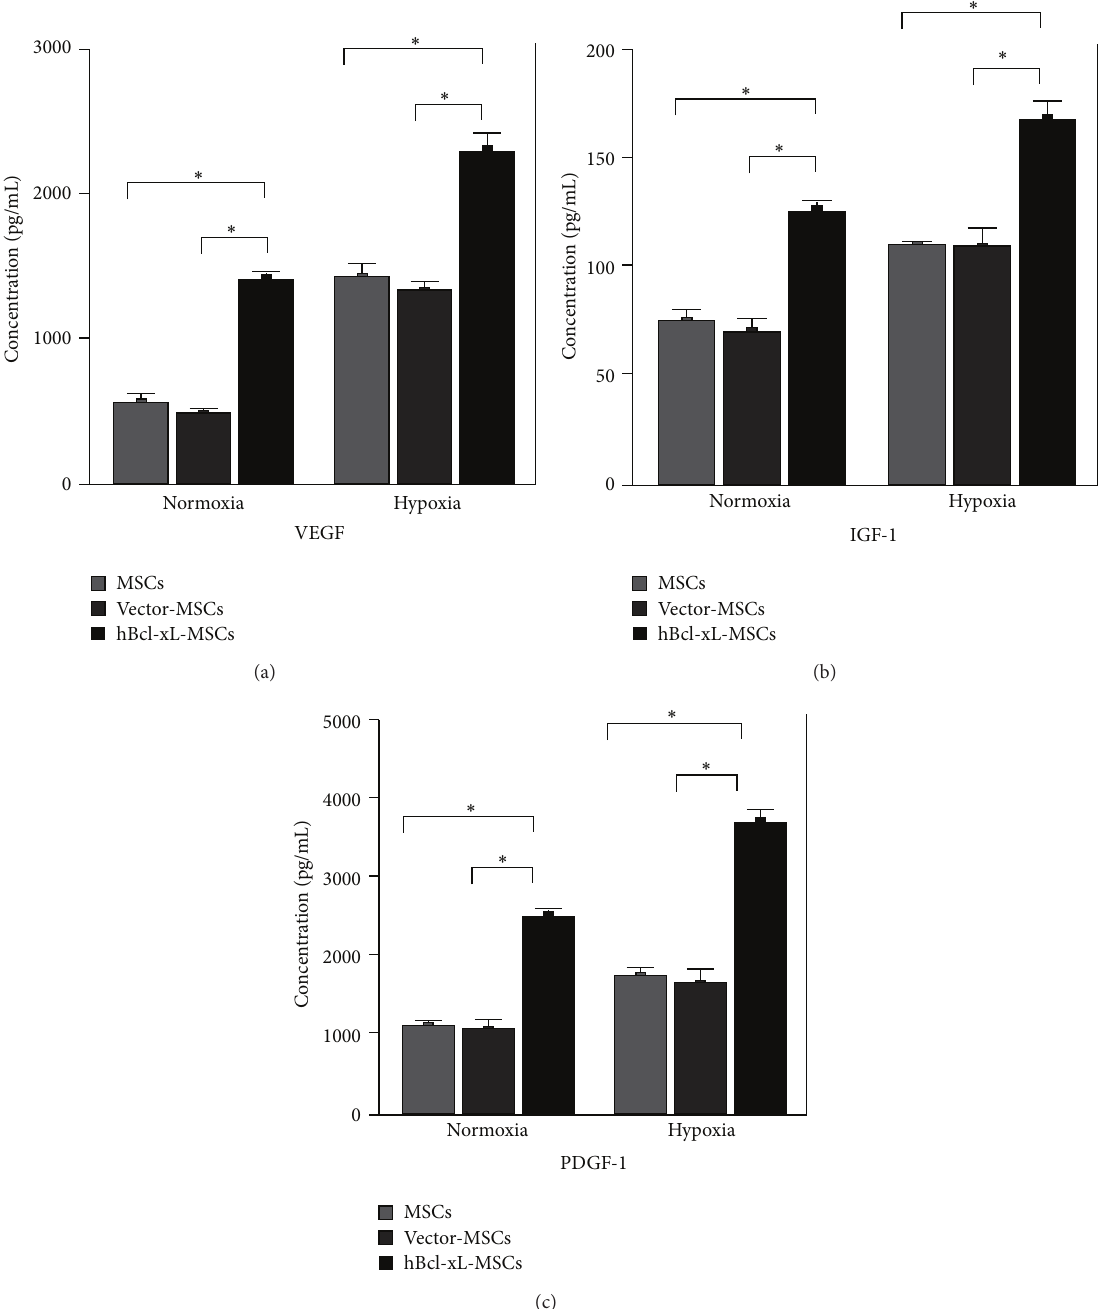
Figure 4: Upregulation of angiogenic cytokines in hBcl-xL-MSCs. ((a)–(c)) Evaluation of the paracrine secretion of VEGF (a), IGF-1 (b), and PDGF (c) by wild type MSCs (pale grey bar), vector-MSCs (dark grey bar), and hBcl-xL-MSCs (black bar). Cells were cultured under either normoxic or hypoxic conditions for 24 hours and the conditioned medium was collected for ELISA. Concentration values are mean ± SD ( 𝑛 = 3 , ∗ 𝑃 < 0.001 ). VEGF: vascular endothelial growth factor; IGF-1: insulin-like growth factor-1; PDGF: plate-derived growth